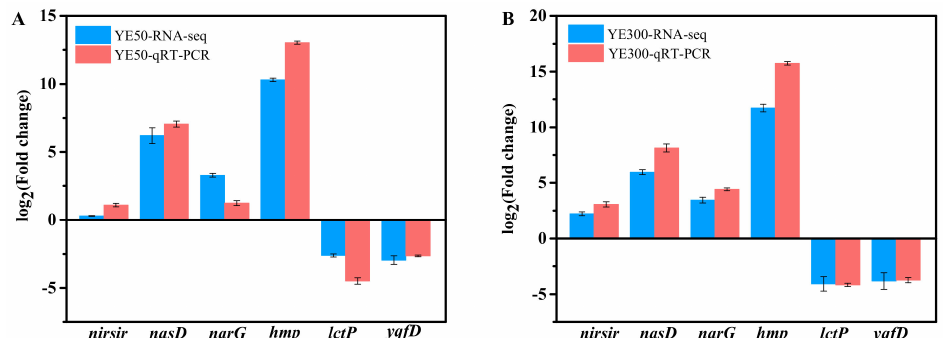
Figure 4. qRT-PCR validation of DEGs of JD-014 under the low concentrations of nitrate YE50 ( A ) and high concentrations of nitrate YE300 ( B ) compared to the control without nitrate during the denitrification process. Six randomly selected genes were nirsir (GE01386), hmp (GE03494), nasD (GE00279), narG (GE00997), lctP (GE00304), and yqfD (GE02214). The plus and minus values represent up-regulated genes and down-regulated genes,